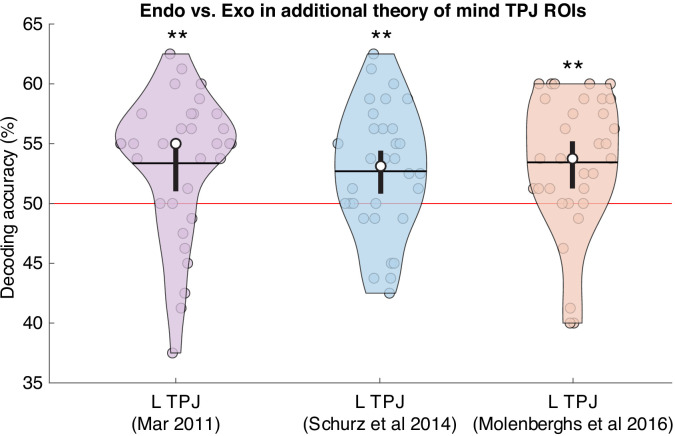
Replicating attention type decoding results in additional TPJ ROIs.To test the robustness of the endogenous-versus-exogenous decoding in the left TPJ, we replicated the results in three ROIs derived from theory-of-mind neuroimaging meta-analyses (Mar, 2011; Molenberghs et al., 2016; Schurz et al., 2014) other than the one used for the main analysis (van Veluw and Chance, 2014). The ROIs were defined as 10-mm-radius spheres around the peak left TPJ coordinates reported in Mar, 2011 (MNI: −53,–56, 22), Schurz et al., 2014 (MNI: −55,–59, 20), and Molenberghs et al., 2016 (MNI: −52,–58, 22). The results showed significant decoding in the Mar ROI (mean decoding accuracy 53.4%, 95% CI 51.0–55.1, p=0.0023), the Schurz ROI (mean decoding accuracy 52.7%, 95% CI 50.8–54.4, p=0.0092), and in the Molenberghs ROI (mean decoding accuracy 53.4%, 95% CI 51.3–55.2, p=0.0020). Violin plots show mean (black horizontal line) and median (white circle) decoding accuracy (%), 95% confidence interval around the mean based on bootstrap distribution (black vertical line), a kernel density estimation (shaded area), and individual data points for the two ROIs. The red horizontal line indicates chance decoding. **p<0.01.